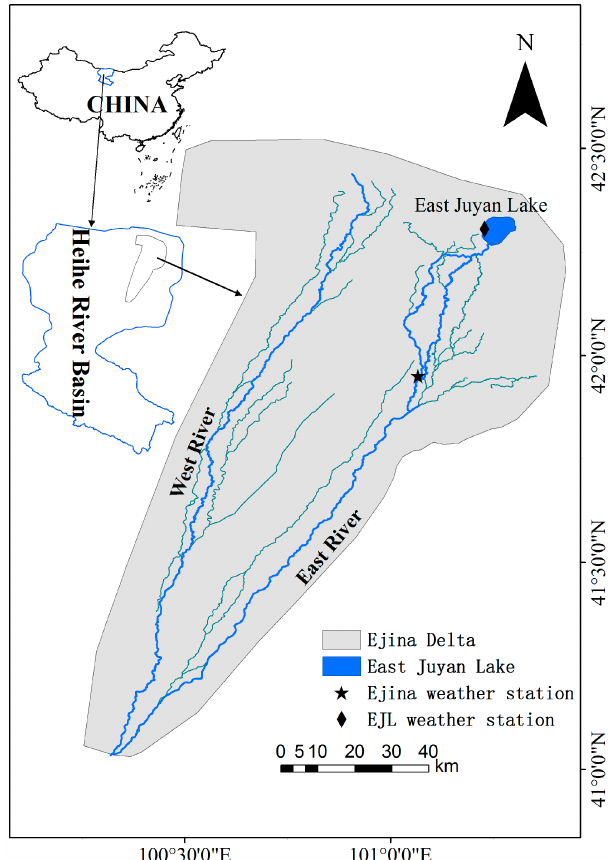
Figure 1. Location of the Ejina Delta and East Juyan Lake.